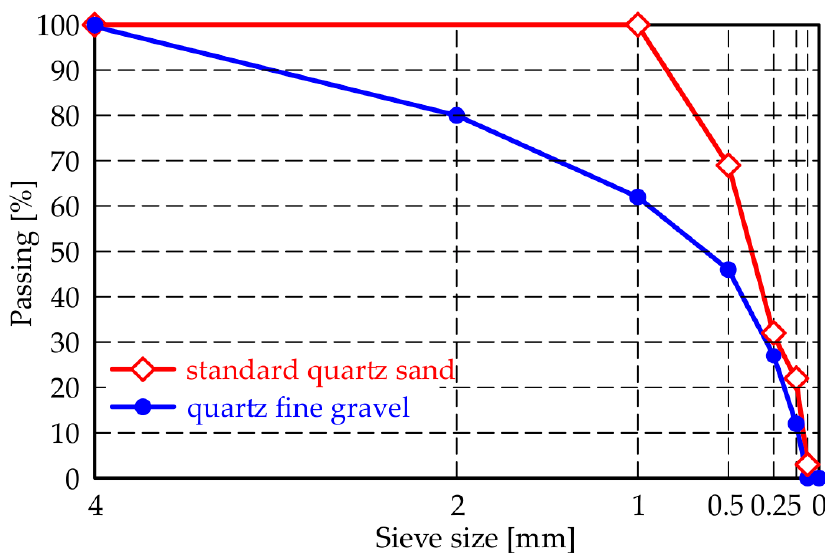
Figure 1. Particle size distribution of the sand and gravel employed in the tested specimens.